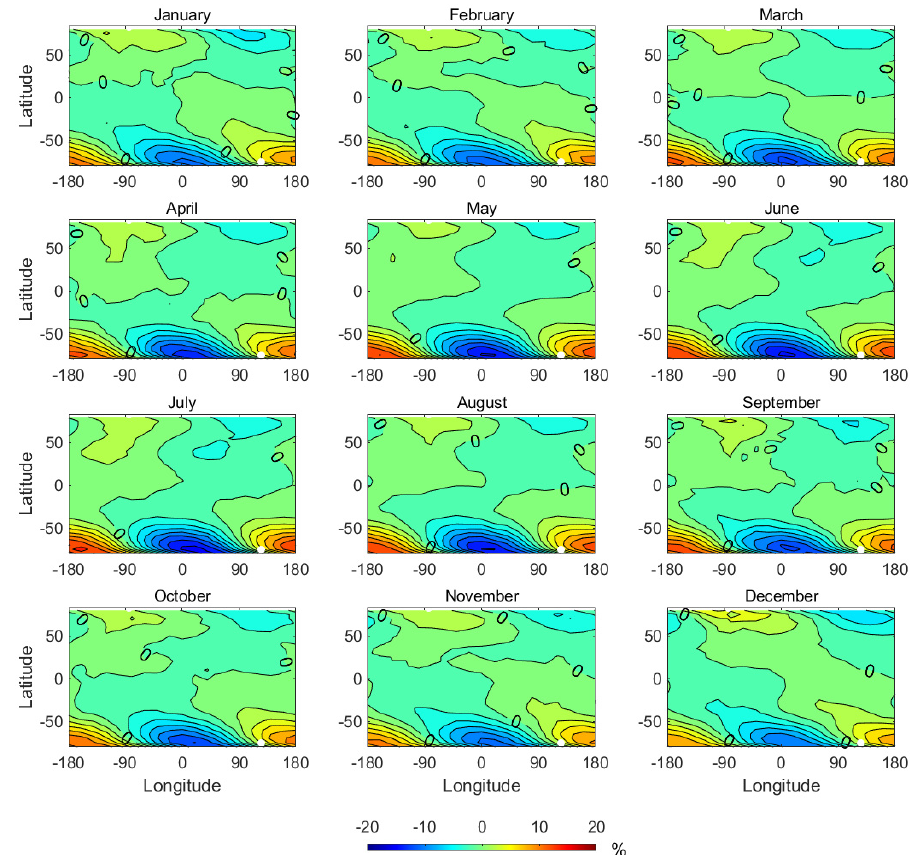
Figure 13. Same as Figure 7, except for the atmospheric temperature.